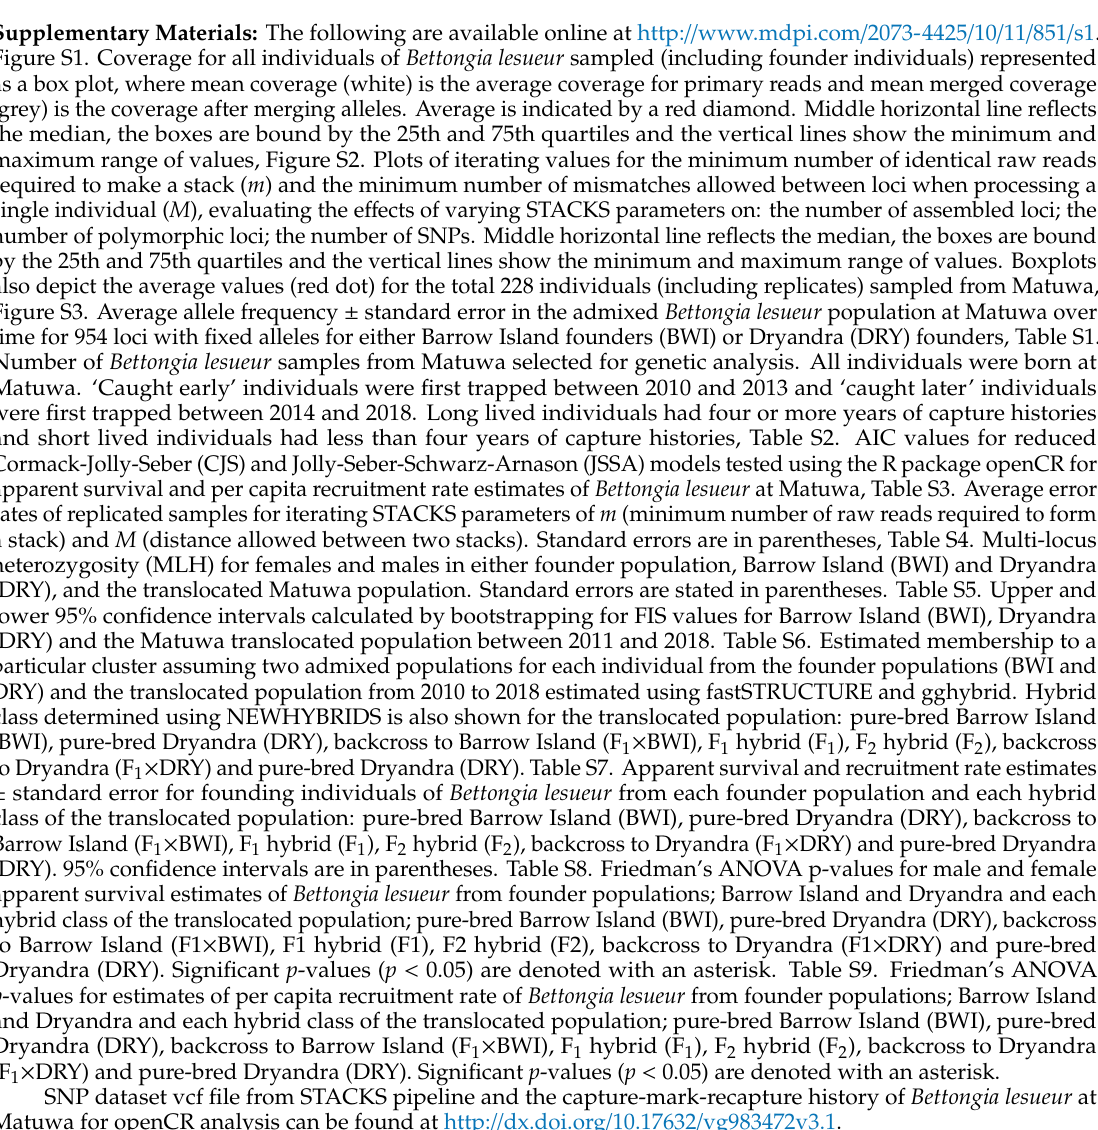
Figure S1. Coverage for all individuals of Bettongia lesueur sampled (including founder individuals) represented as a box plot, where mean coverage (white) is the average coverage for primary reads and mean merged coverage (grey) is the coverage after merging alleles. Average is indicated by a red diamond. Middle horizontal line reflects the median, the boxes are bound by the 25th and 75th quartiles and the vertical lines show the minimum and maximum range of values, Figure S2. Plots of iterating values for the minimum number of identical raw reads required to make a stack ( m ) and the minimum number of mismatches allowed between loci when processing a single individual ( M ), evaluating the e ff ects of varying STACKS parameters on: the number of assembled loci; the number of polymorphic loci; the number of SNPs. Middle horizontal line reflects the median, the boxes are bound by the 25th and 75th quartiles and the vertical lines show the minimum and maximum range of values. Boxplots also depict the average values (red dot) for the total 228 individuals (including replicates) sampled from Matuwa, Figure S3. Average allele frequency ± standard error in the admixed Bettongia lesueur population at Matuwa over time for 954 loci with fixed alleles for either Barrow Island founders (BWI) or Dryandra (DRY) founders, Table S1. Number of Bettongia lesueur samples from Matuwa selected for genetic analysis. All individuals were born at Matuwa. ‘Caught early’ individuals were first trapped between 2010 and 2013 and ‘caught later’ individuals were first trapped between 2014 and 2018. Long lived individuals had four or more years of capture histories and short lived individuals had less than four years of capture histories, Table S2. AIC values for reduced apparent survival and per capita recruitment rate estimates of Bettongia lesueur at Matuwa, Table S3. Average error rates of replicated samples for iterating STACKS parameters of m (minimum number of raw reads required to form a stack) and M (distance allowed between two stacks). Standard errors are in parentheses, Table S4. Multi-locus heterozygosity (MLH) for females and males in either founder population, Barrow Island (BWI) and Dryandra (DRY), and the translocated Matuwa population. Standard errors are stated in parentheses. Table S5. Upper and lower 95% confidence intervals calculated by bootstrapping for FIS values for Barrow Island (BWI), Dryandra (DRY) and the Matuwa translocated population between 2011 and 2018. Table S6. Estimated membership to a particular cluster assuming two admixed populations for each individual from the founder populations (BWI and DRY) and the translocated population from 2010 to 2018 estimated using fastSTRUCTURE and gghybrid. Hybrid class determined using NEWHYBRIDS is also shown for the translocated population: pure-bred Barrow